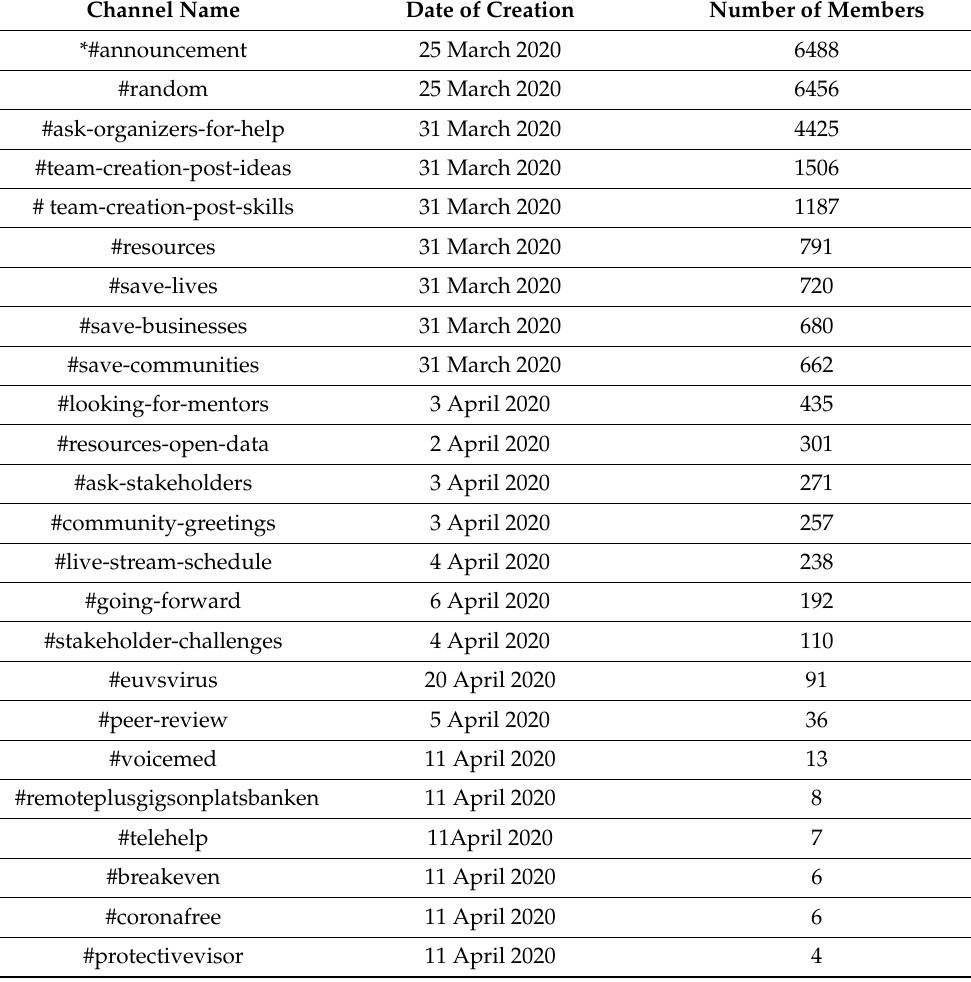
Table A2. Channel List.